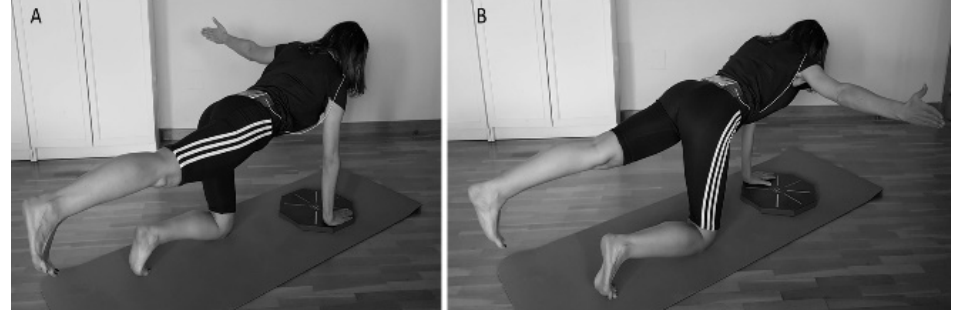
Figure 1. Bird-dog (BD) test. Variation of bird-dog exercise test raising the left ( A ) and ( B ) right arm to the side following the direction of the OctoBalance ® line.